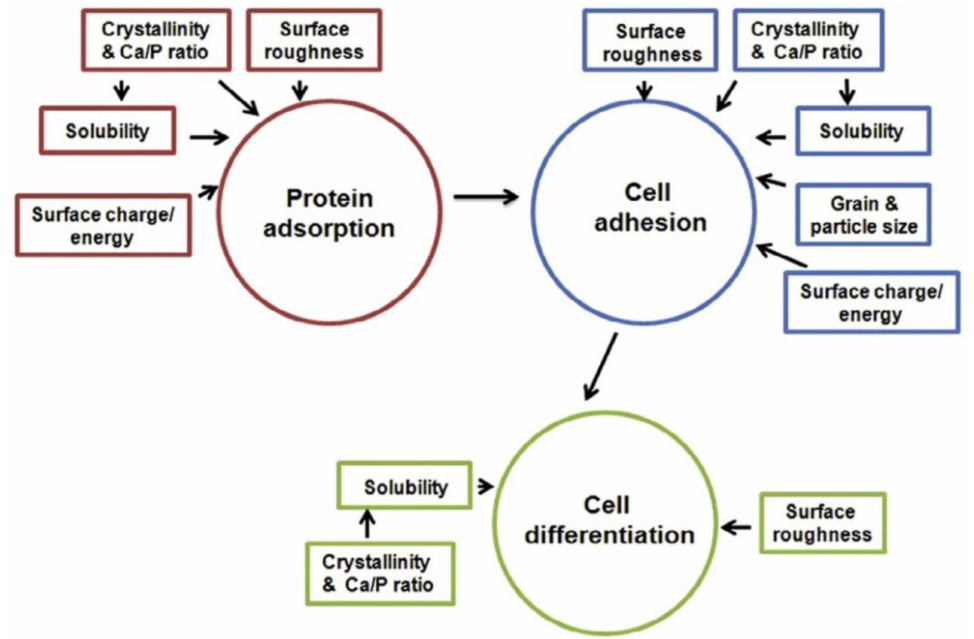
Figure 23. A schematic drawing of the key scaffold properties affecting a cascade of biological processes occurring after CaPO 4 implantation. Reprinted from Ref. [807] with